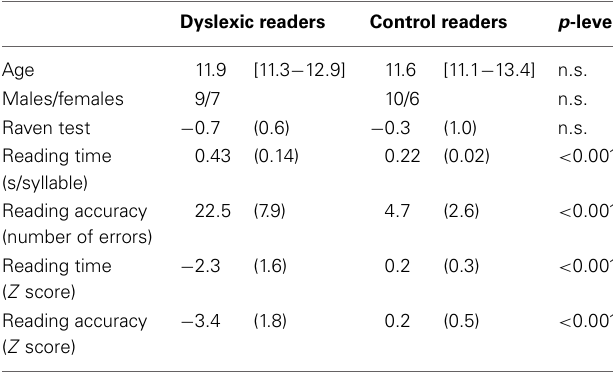
Table 1 | Summary statistics for the two groups of participants: mean age (in years, with range in square brackets); number of female and male participants; mean z -scores (and SD in parentheses) on Raven’s Colored Matrices; mean reading times and mean number of errors on the MT Reading test; mean z -scores for reading time and accuracy on the same